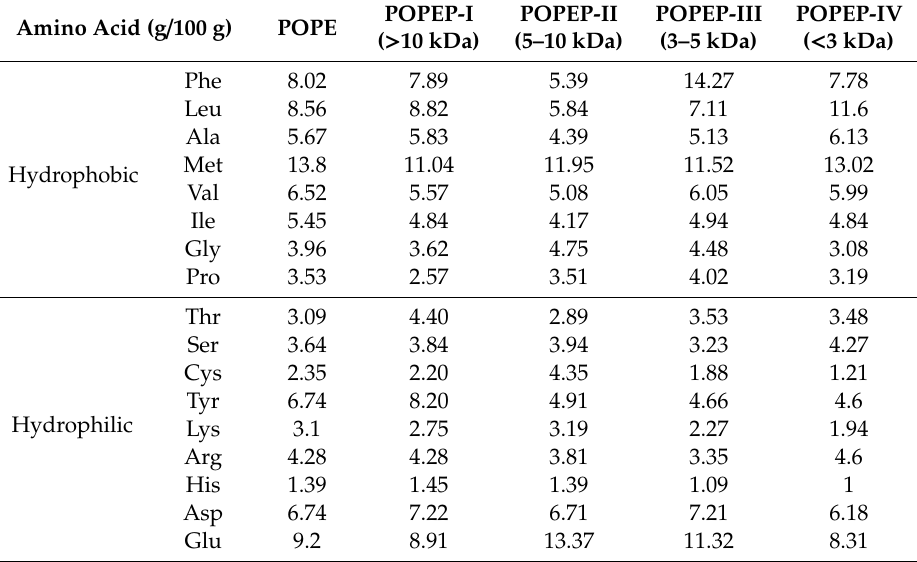
Table 2. Amino acid compositions of POPE and ultrafiltrated POPEP fractions. Amino Acid (g / 100